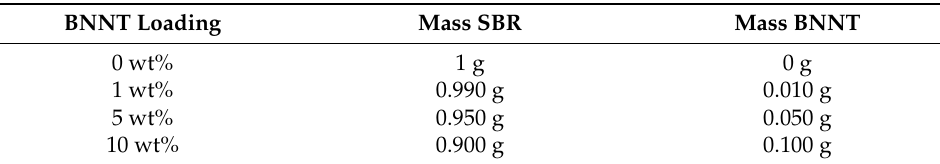
Table 2. Nomenclatures of composites prepared.